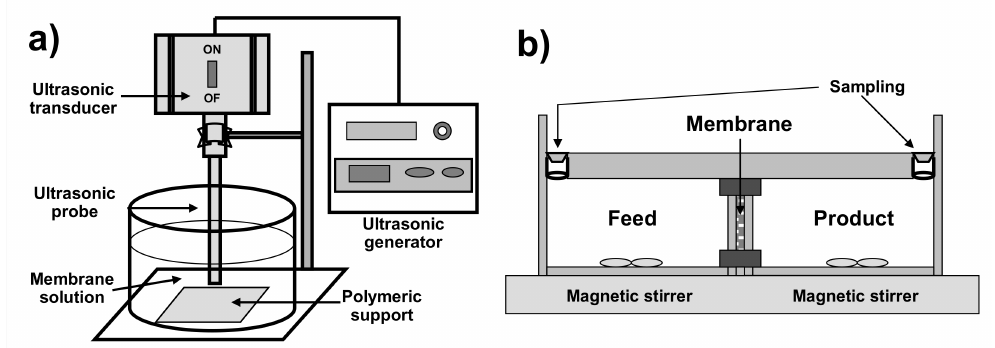
Figure 2. Schematic representations of: ( a ) sonication system; ( b ) experimental transport